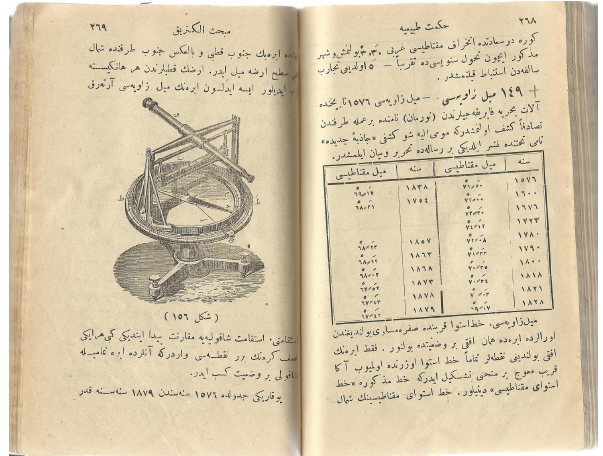
Figure 3d. A page from Hikmet-i Tabiye (Physics or Natural Phi- losophy) (from my own library).